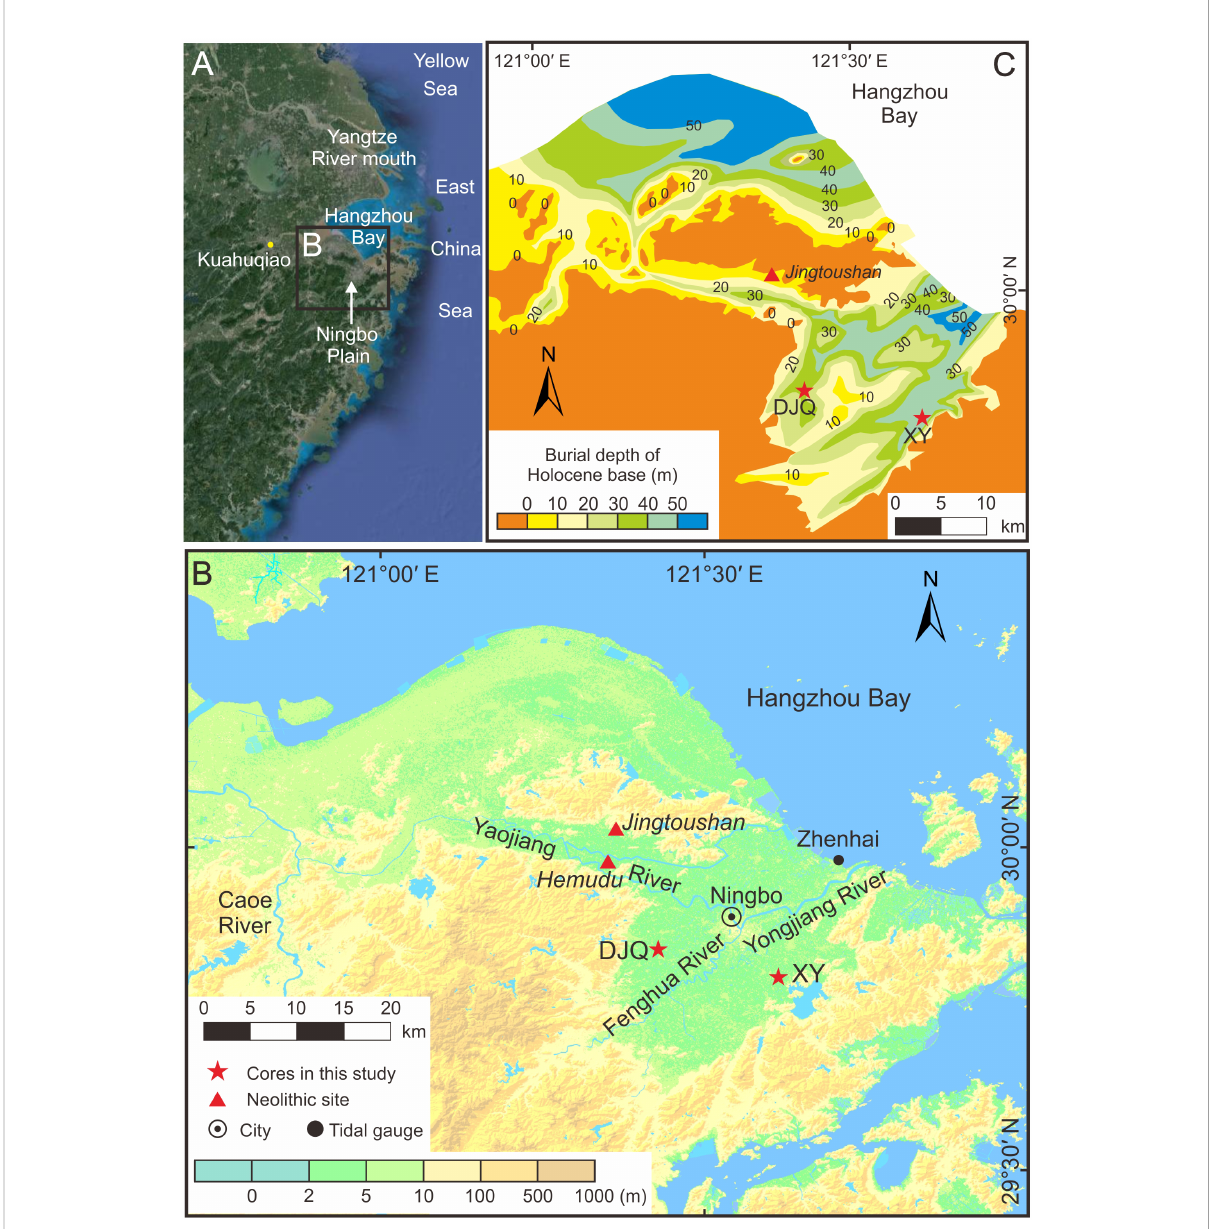
FIGURE 1 Location of (A) the study area and the Kuahuqiao site and (B) the Neolithic Jingtoushan and Hemudu sites and sediment cores. (C) Buried depth of the Holocene base, which is identi fi ed from the stiff mud of palaeosol and river channel gravelly sand formed during the late Pleistocene (after Xu, 1987; Yan,